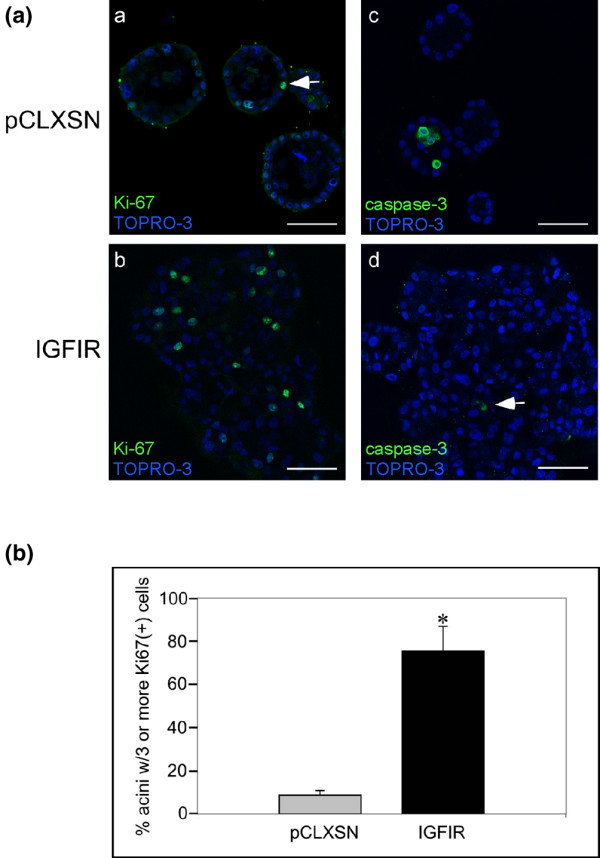
Increased proliferation and decreased luminal apoptosis in IGFIR structures. (a) Confocal sections of 34-day acinar structures from control (pCLXSN; panels a, c), and IGFIR-expressing (panels b, d) MCF-10A cells labeled with antibodies to the proliferative marker Ki-67 (green; panels a, b) or cleaved caspase-3 (green; panels c, d) and the nuclear counterstain TO-PRO-3 (blue). Scale bars = 50 μm. Arrows indicate a Ki-67-labeled cell (panel a) and a cleaved caspase-3 labeled cell (panel d). (b) Bar graph showing the percent of acini with three or more Ki-67-positive cells in control and IGFIR-expressing structures. Data are mean ± standard deviation from three different experiments grown for 20 days from two independently derived cell lines. At least 100 acini were counted in each experiment; the asterisk indicates significance, p < 0.01, Student's t test.